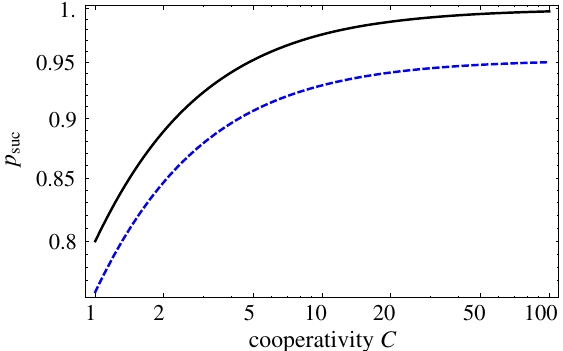
FIG. 14. Success probability p for a qubit excitation to suc leak through the mirror, as a function of the cooperativity 0 (black solid line) and ε ¼ 5% (blue C for ε ¼ κ = κ bd gd ¼ dashed